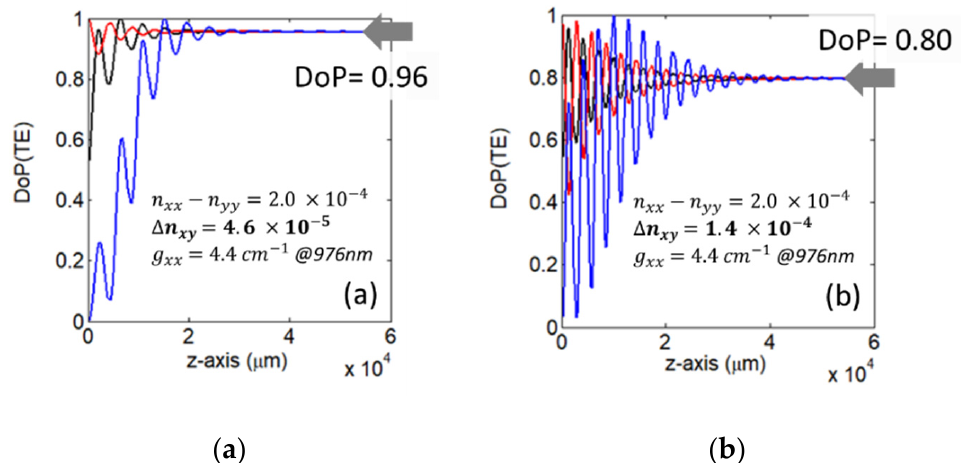
(0); 𝜓 (0)(cid:3439) . (cid:3051) (cid:3052)